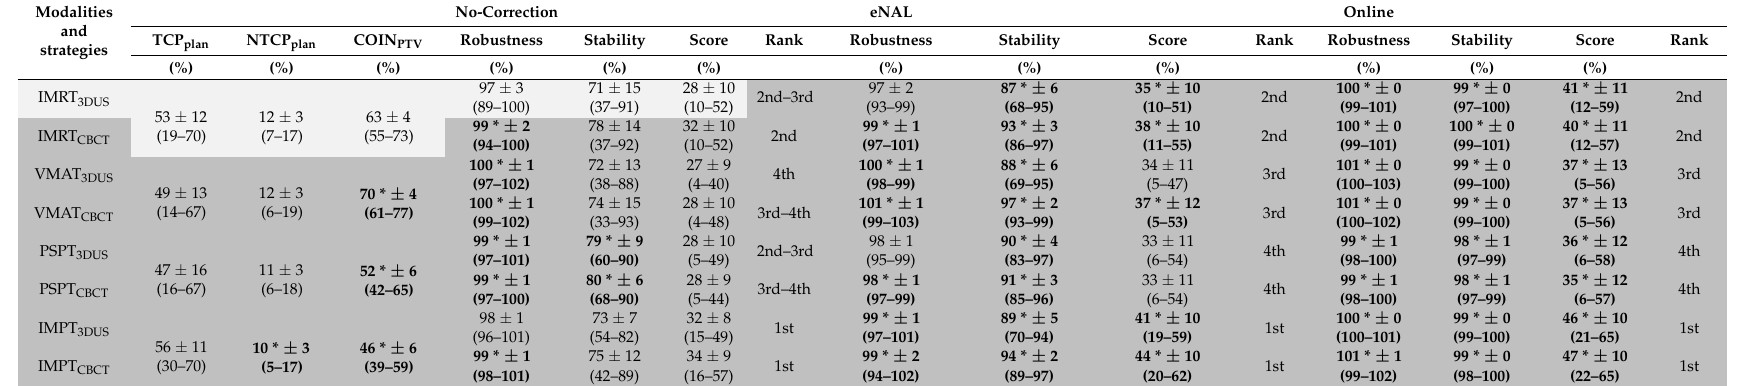
Table 2. Inter-modality evaluation and ranking at the cohort